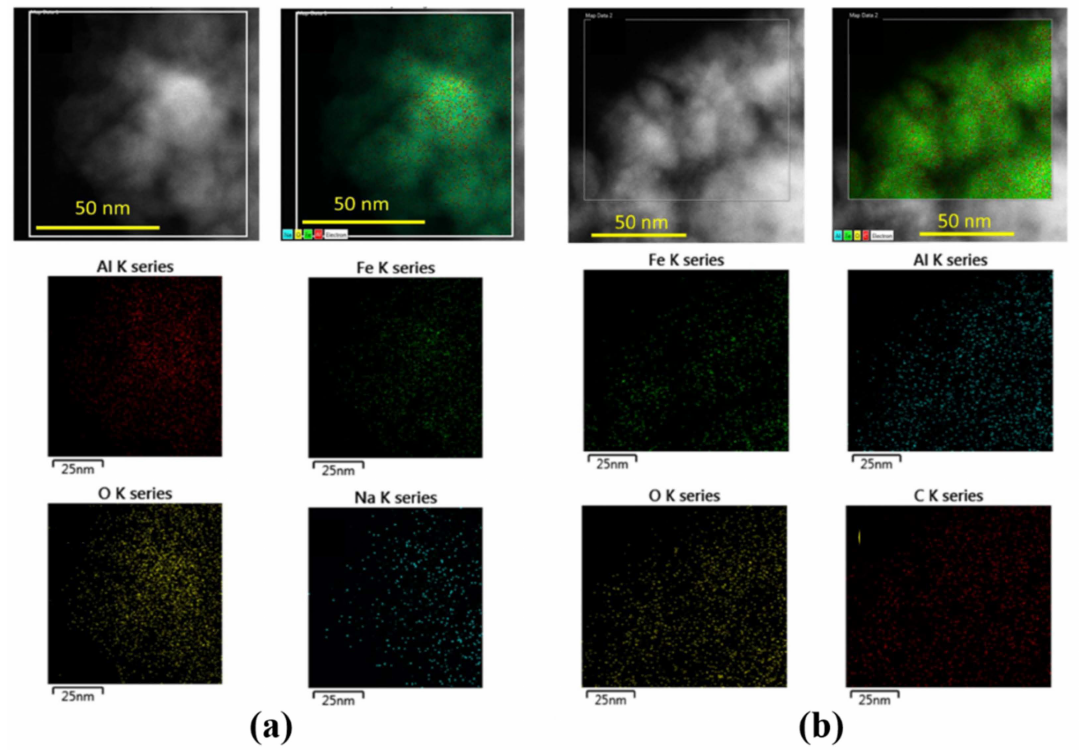
Figure 6. TEM-EDS images of the reduced ( a ) and spent ( b ) FeAlO x -5 catalysts. Reprinted with permission from Khan et al. [49]. Copyright (2020) American Chemical